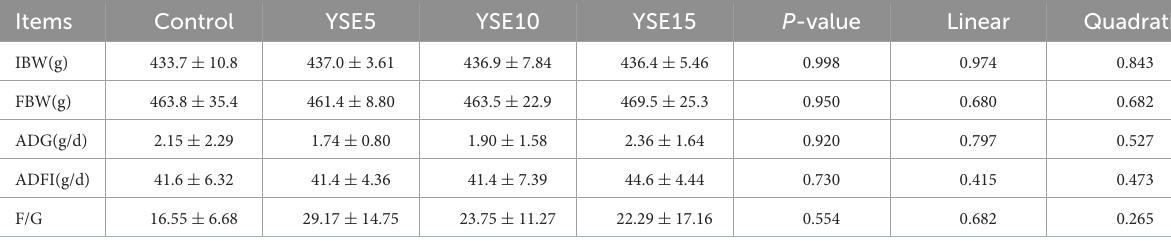
TABLE 2 The effect of supplemental different levels of YSE on the growth performance of young pigeons a . Items Control P -value Linear Quadratic